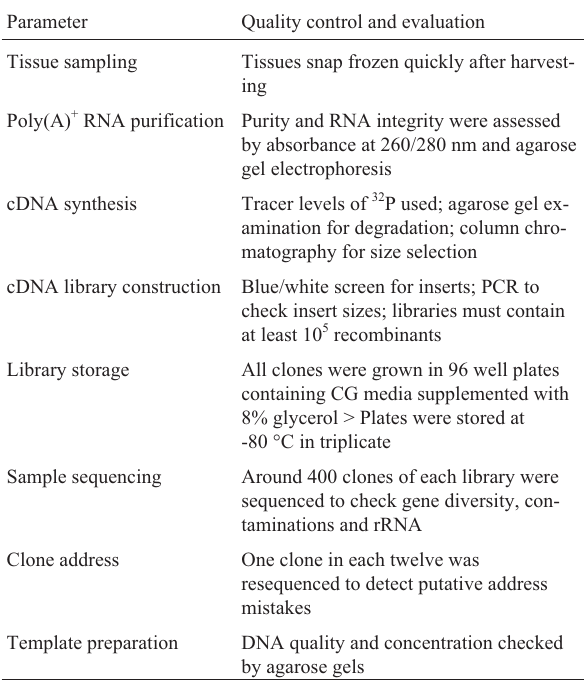
Table II - Quality control and evaluation of SUCEST